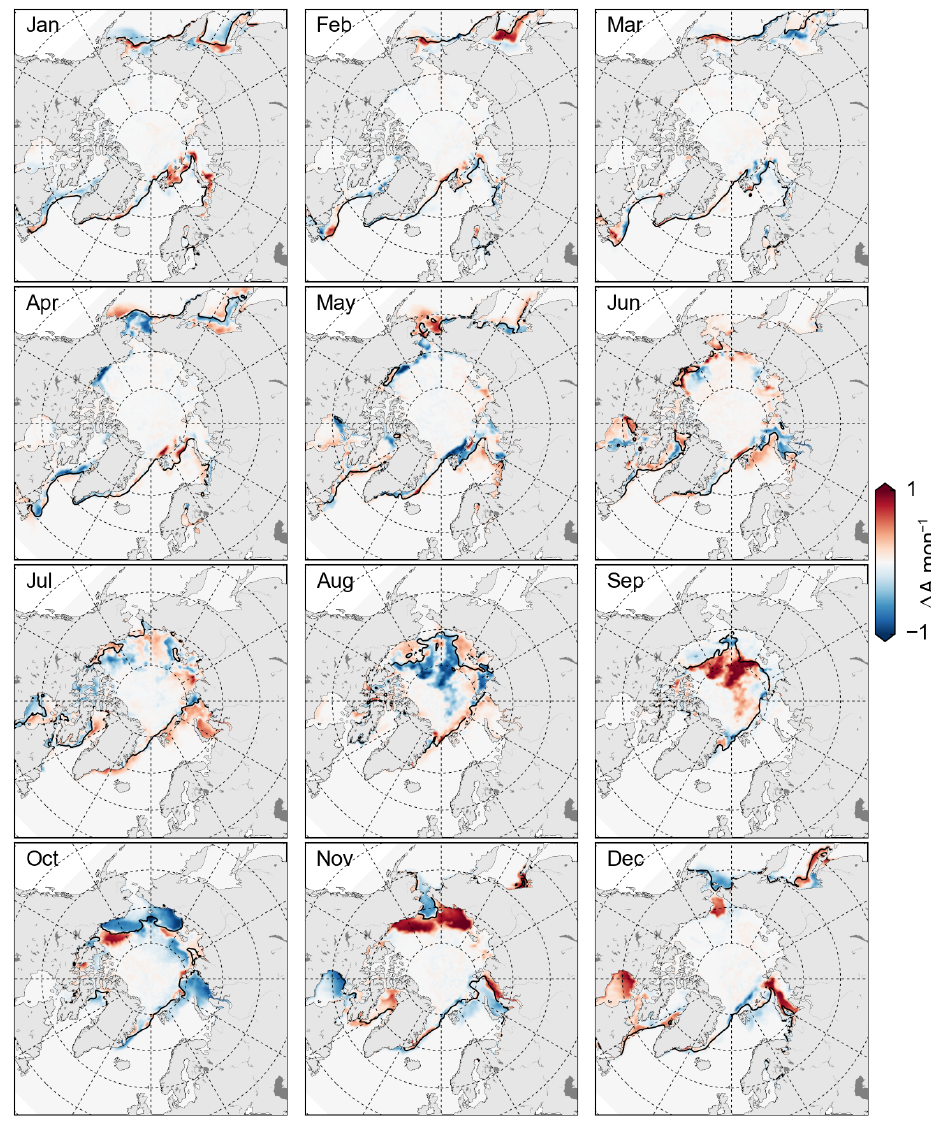
Figure 6. Monthly 2016 sea ice intensification anomalies, relative to the 2000–2015 mean, calculated using the daily Bootstrap sea ice concentration data. Positive values (red) denote more ice gain in a given grid cell compared to the mean. The units are concentration per month. The black contour indicates the monthly 2016 sea ice edge (0.15 ice concentration